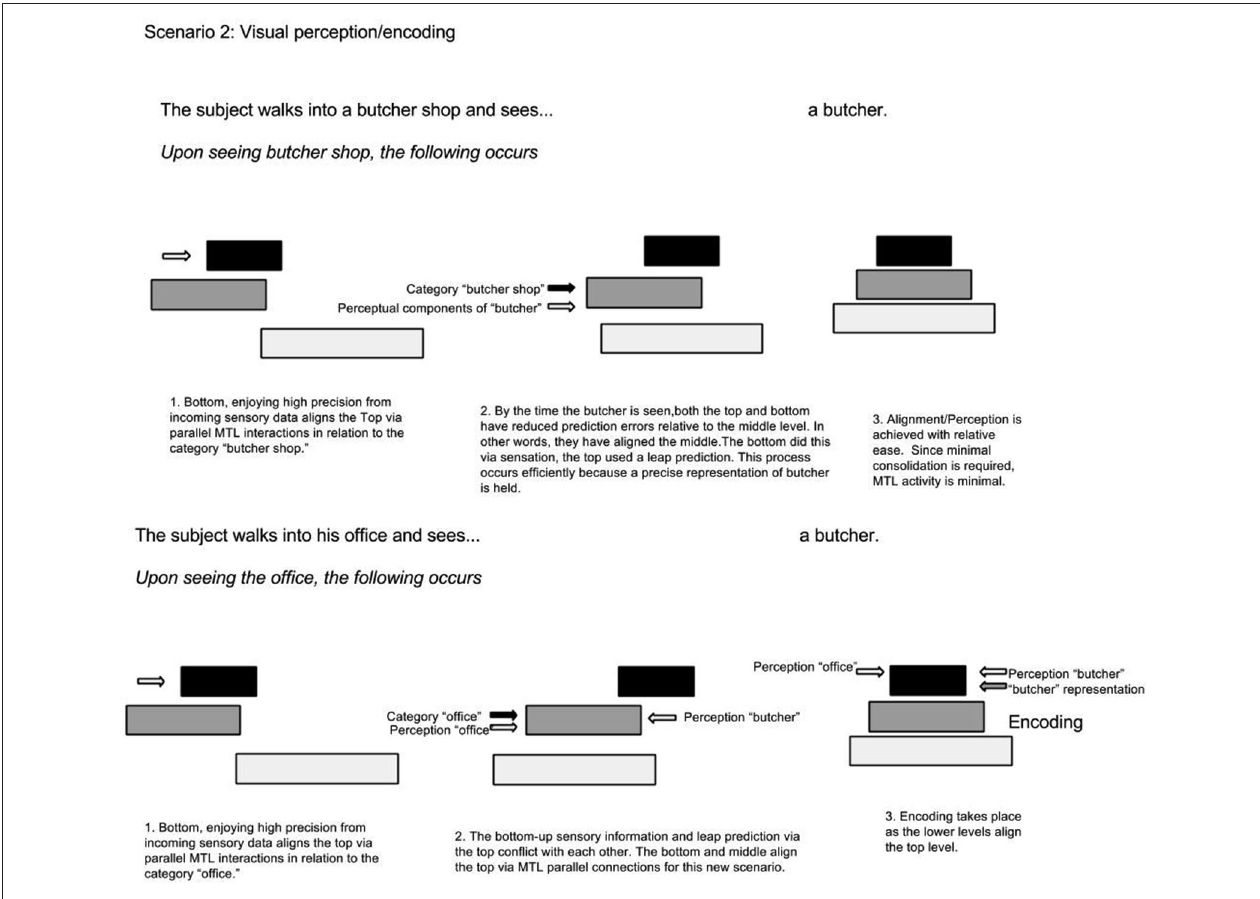
scenario where the top representation does not accurately predict the situation; as a result, it becomes updated by lower levels via the